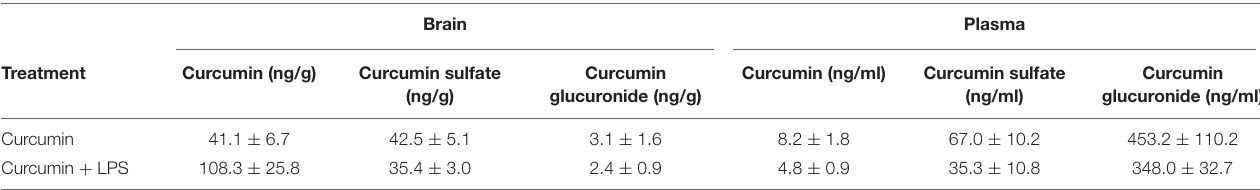
TABLE 2 | Detection of curcumin and its metabolites in brain and plasma.